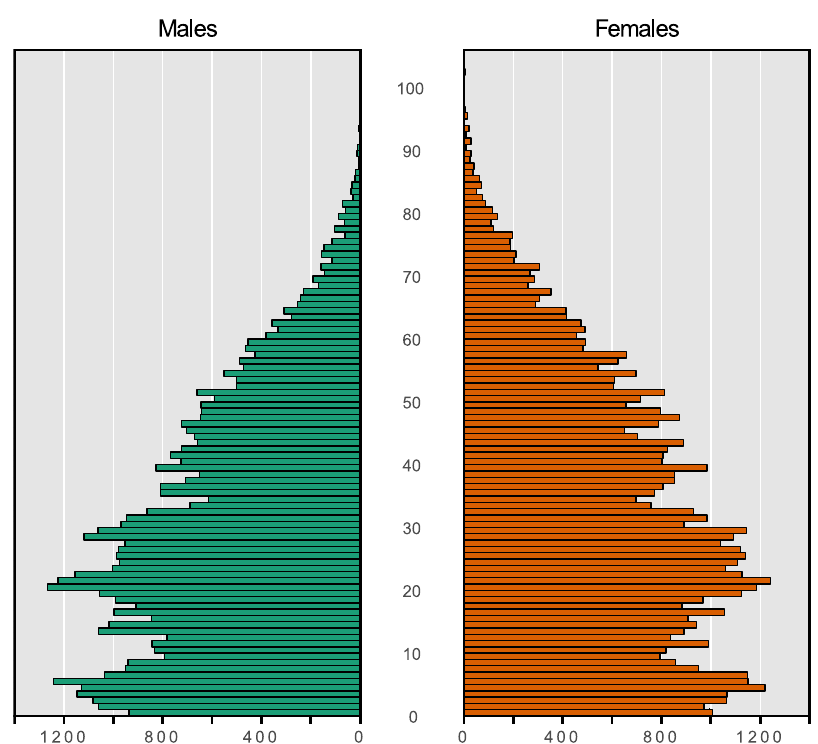
Fig. 2 Age pyramid of the simulation model agents. The green horizontal bars on the left indicate the absolute numbers of male agents for each year of age. The orange horizontal bars on the right show respective years of age for female